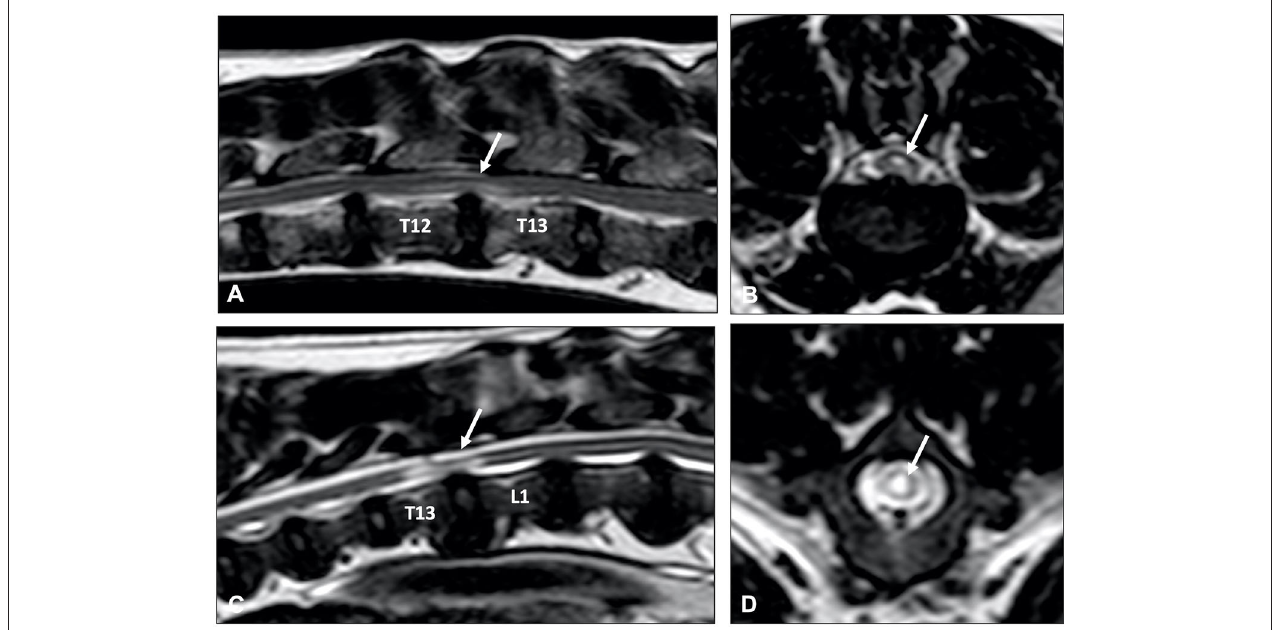
FIGURE 9 | Sagittal (A,C) and transverse (B,D) T2-weighted MR images of a 9-year old Labrador retriever (A,B) and an 11-year old Poodle (C,D) with thoracolumbar IVDP. A poorly demarcated, diffuse intraparenchymal hyperintensity is seen overlying the affected intervertebral disc (arrow) in the Labrador retriever, while a well-demarcated and bright intraparenchymal hyperintensity is seen in the Poodle (arrow). It is currently unclear if this difference in intraparenchymal intensity characteristics is associated with differences in clinical presentation or outcome.